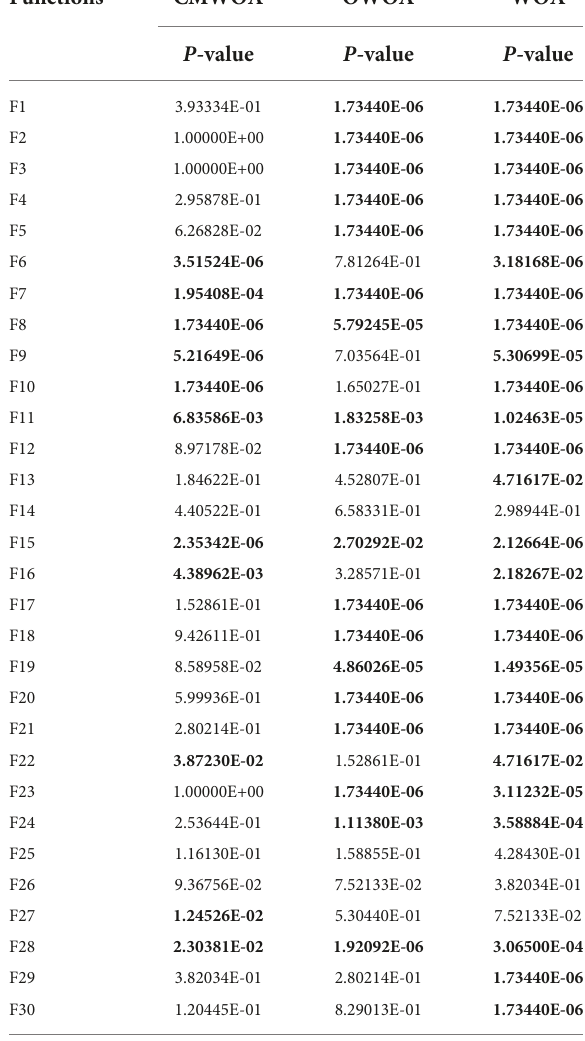
TABLE 6 P -values of COWOA on the Wilcoxon